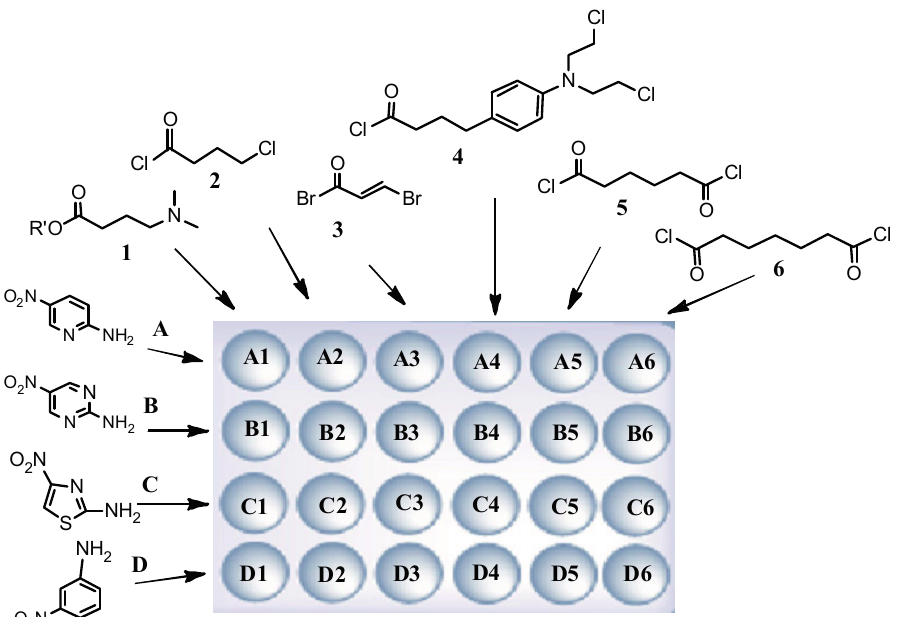
Figure 2. Structures of substrates and the synthesis